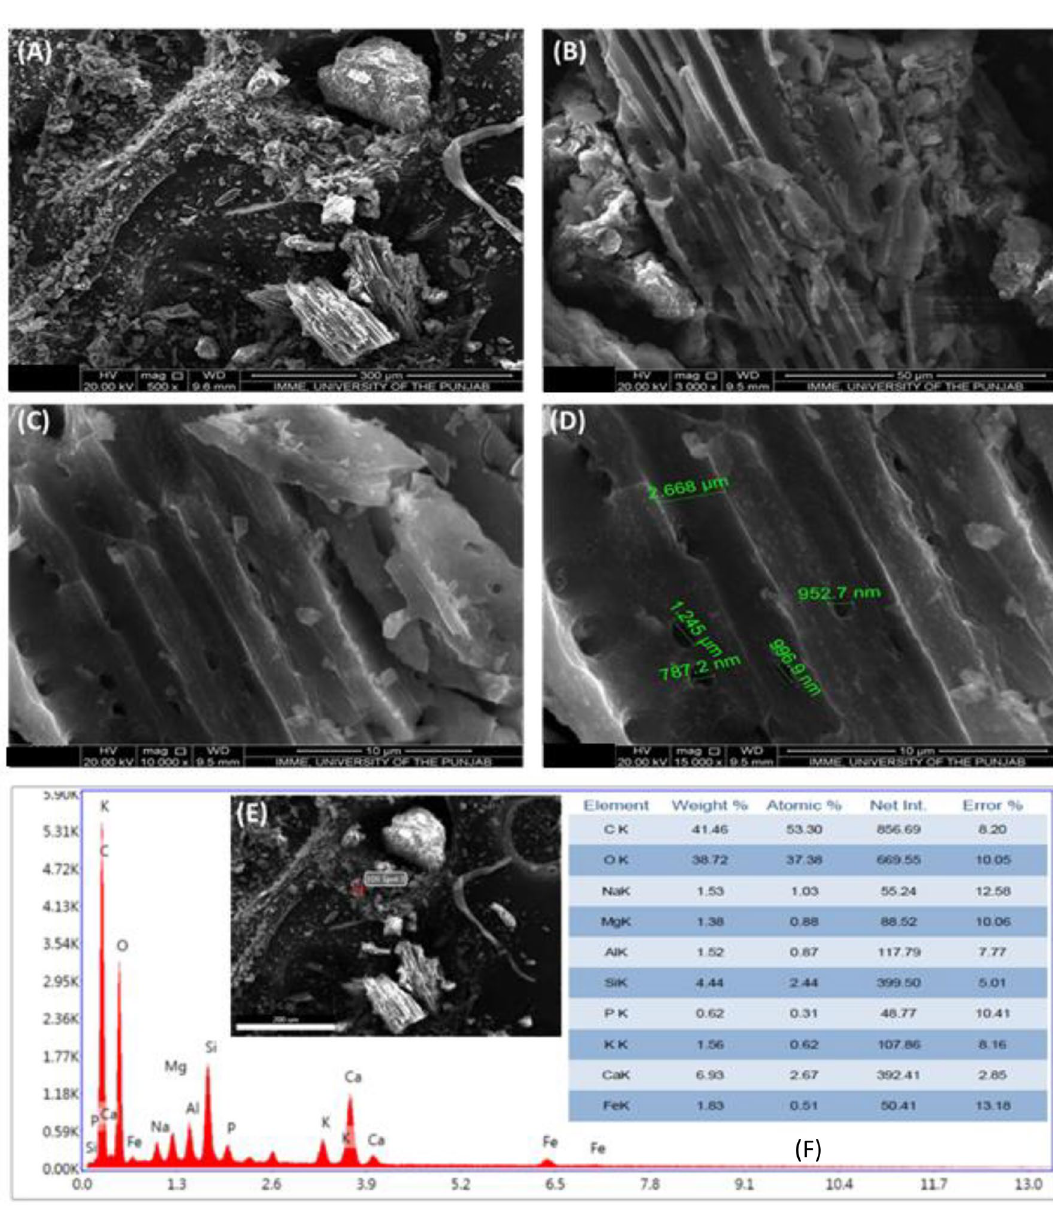
Figure 7. SEM images of